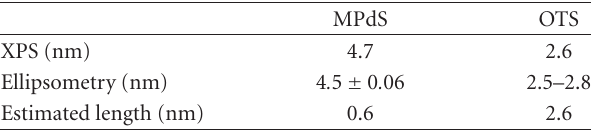
Table 2: Thickness